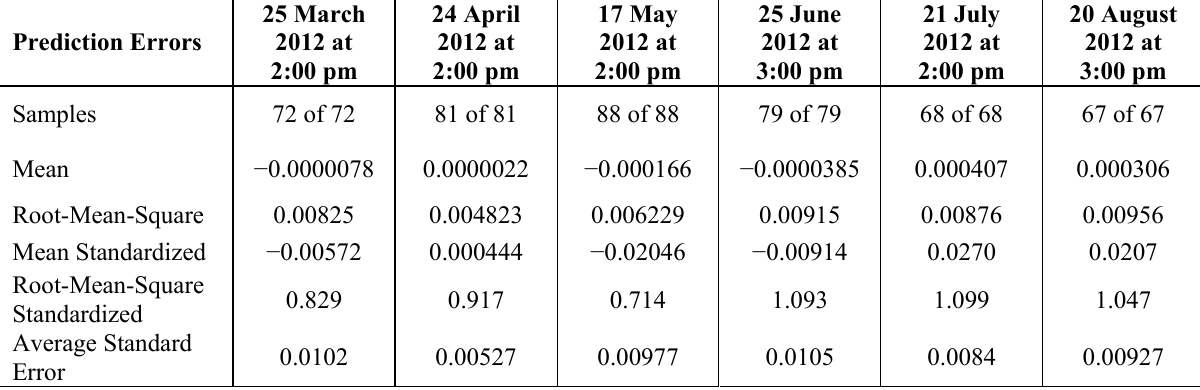
Table 2. Prediction error statistics for the selected hours of spring and summer